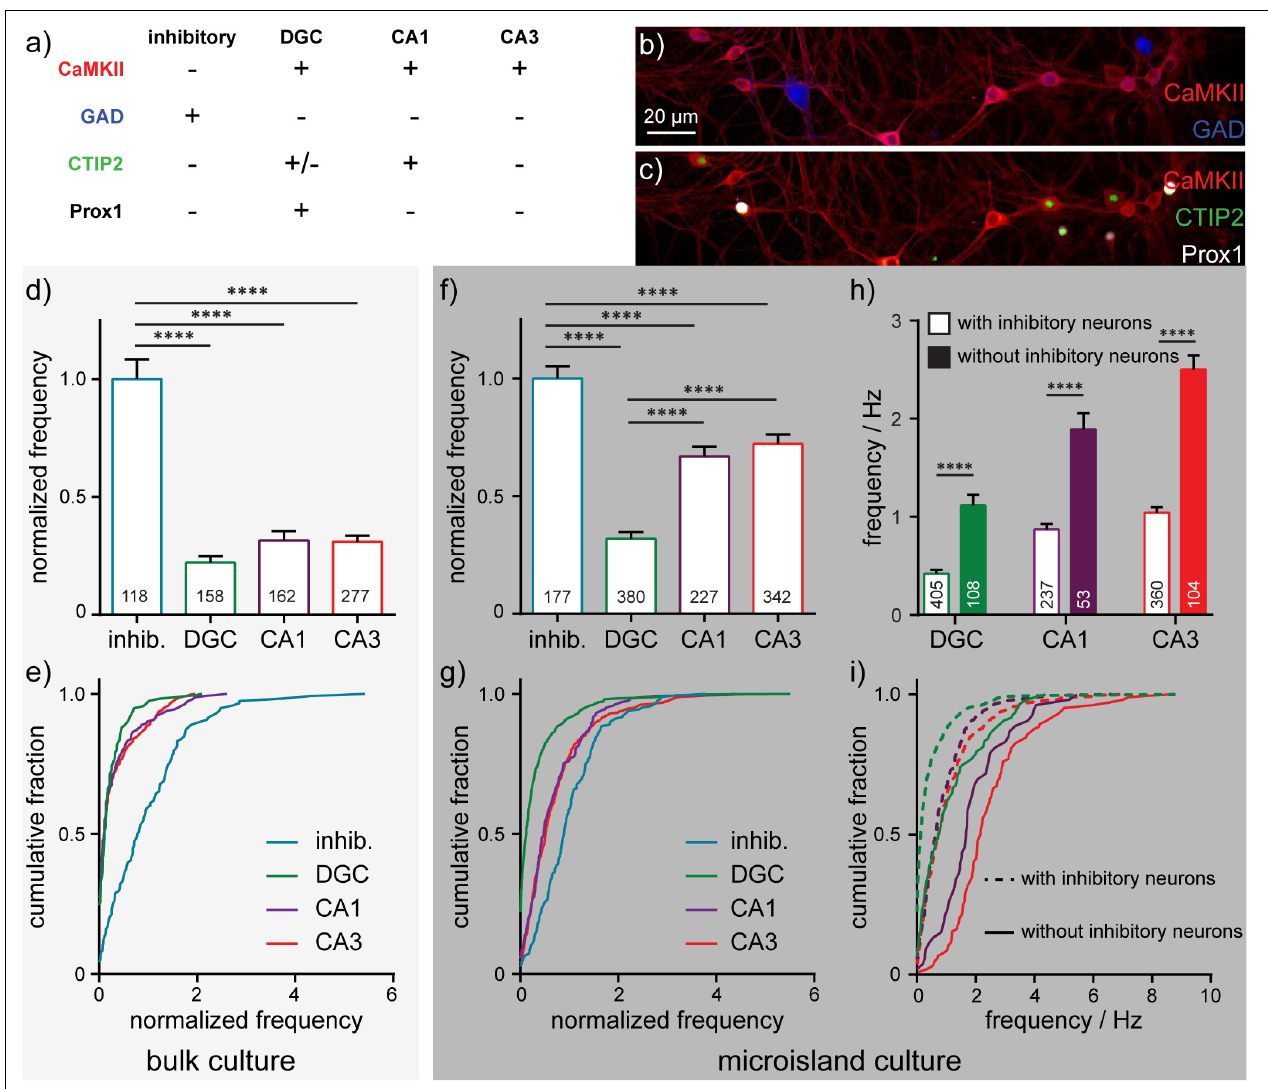
FIGURE 4 | Cell-type dependent activity profiles interrogated by BeRST 1 voltage imaging. (a) Assignment of hippocampal cell type by post hoc analysis of cell type by immunofluorescence using anti-CaMKII, anti-GAD, anti-CTIP2, and anti-Prox1 antibodies. Images are of neurons fixed after functional imaging with BeRST 1 (as in Figure 1 ) and then stained for (b) CaMKII (red) and GAD (blue) or (c) CaMKII (red), CTIP2 (green), and Prox1 (white). Action potential frequencies for different cell types—inhibitory (“inhib.”, teal), dentate granule cells (“DGC,” green), CA1 (purple), and CA3 (red) pyramidal neurons—are summarized either as bar graphs for neurons grown (d) on 35 mm diameter coverslips and (f) in microislands containing at least 1 inhibitory neuron and as cumulative frequency plots for neurons (e) on coverslips or (g) in microislands. Numbers in bar graphs indicate the number of neurons analyzed across n = 5 (coverslips) or 11 (microislands) independent experiments (biological replicates). The difference in action potential frequency recorded from neurons in microislands with or without inhibitory neurons is summarized as (h) a bar graph or (i) cumulative frequency plot. Empty bars (h) and dashed lines (i) indicate values for microislands with at least 1 inhibitory neuron. Filled bar (h) and solid lines (i) indicate values for microislands without identifiable inhibitory neurons. Frequency, where indicated, is normalized to the frequency of inhibitory neurons measured for each biological replicate. Statistical tests are Kruskal-Wallis ANOVAs with multiple comparison tests to all groups (d,f)